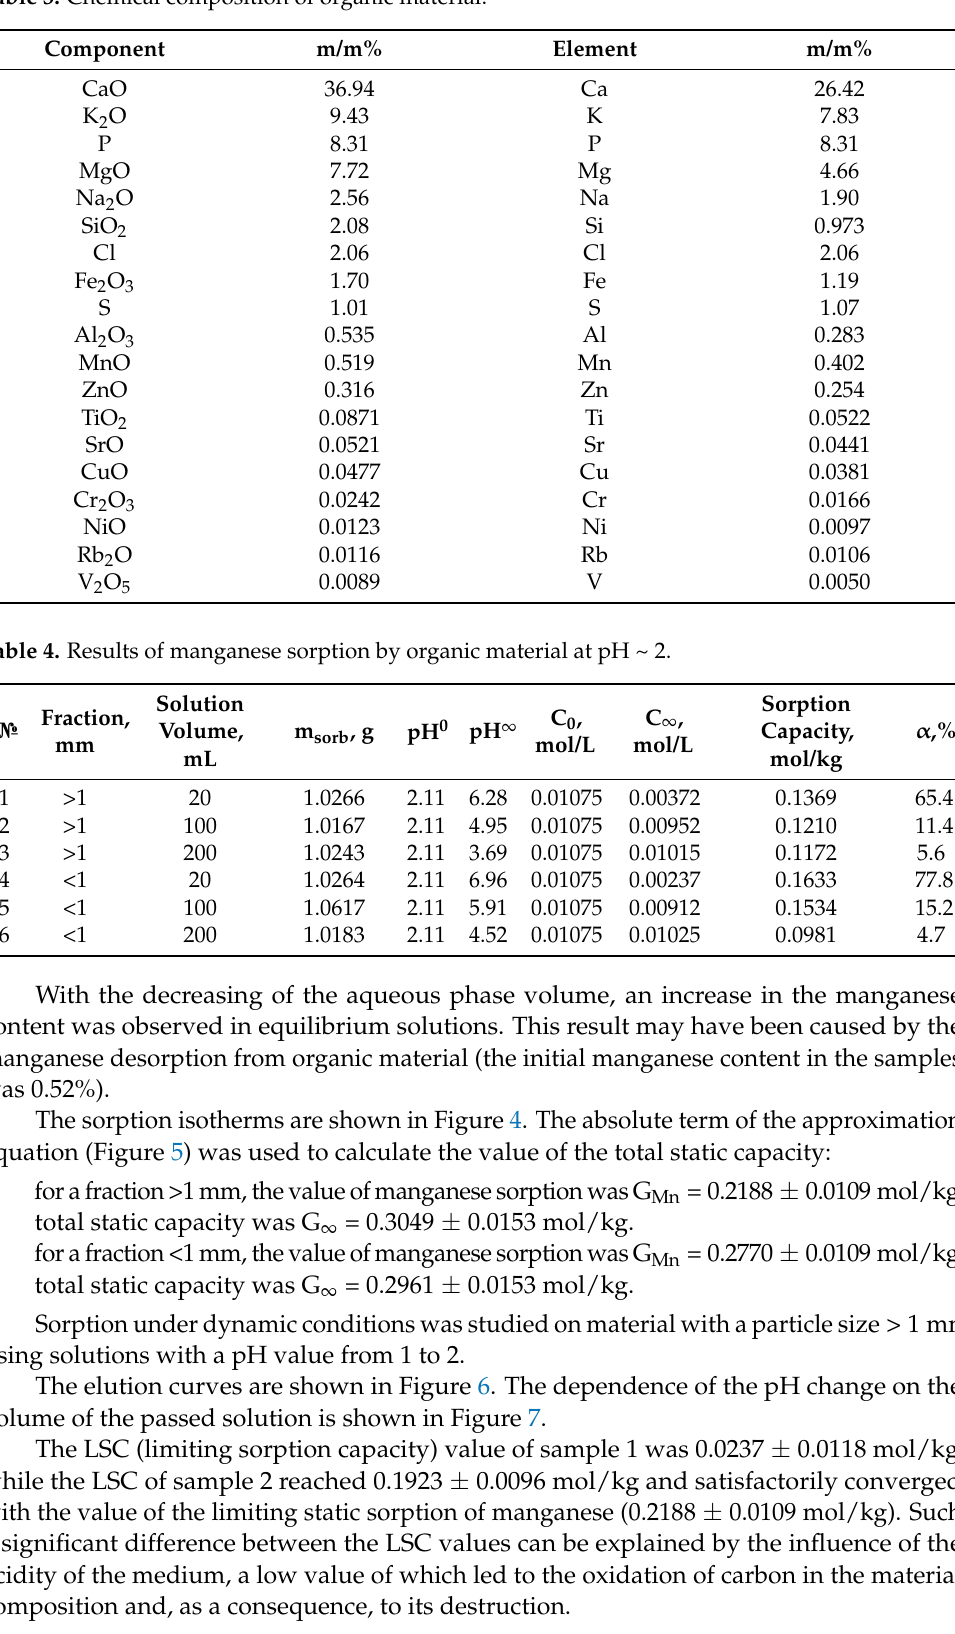
Table 3. Chemical composition of organic material.